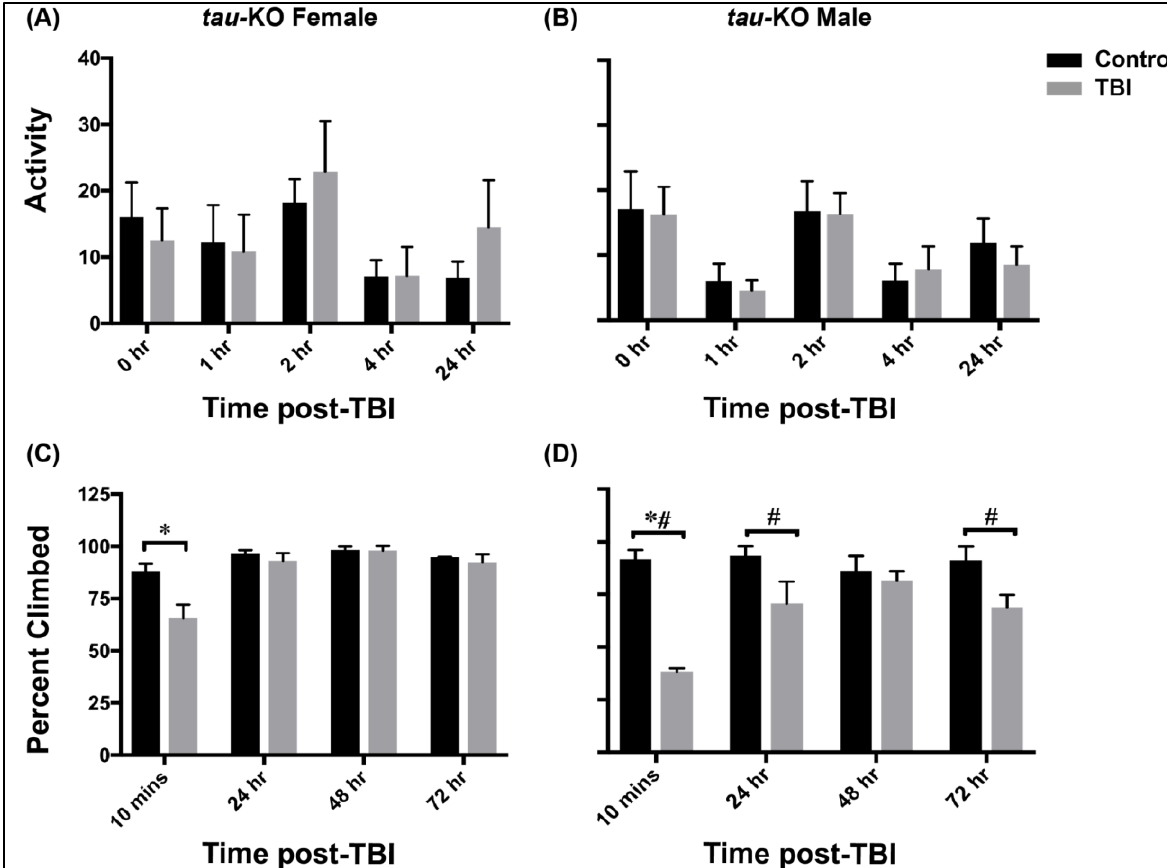
Figure 1. Tau -KO male and female flies exhibit varied outcomes to motor function assay. ( A , B ) Locomotor activity plots for tau -KO female ( A ) and male ( B ) flies after TBI. Average locomotor activity (the number of times a fly crosses the infrared beam in the 30-min before the time-point) is depicted for the first 24-h after injury as mean ± SEM (n > 20). We did not see a significant effect of TBI on locomotion (repeated measures ANOVA with LSD and Bonferroni). ( C , D ) Climbing ability of tau -KO female ( C ) and male ( D ) flies after TBI. Twenty flies per condition (male and female; control and post TBI; 3 replicate vials each) were placed in plastic vials and each vial was assessed at four time points: 10 min, 24-, 48- and 72 h after TBI. The average percent climbed across all 3 replicates is reported as mean ± SEM (each replicate consists of 20 flies; total 60 flies). Both sexes exhibit decreases in climbing ability 10 min after injury (* p < 0.05 with two-way ANOVA and # p < 0.05 with mixed design ANOVA and TukeyHSD). Males show lasting defects up to 72 h (Mixed design ANOVA with TukeyHSD).